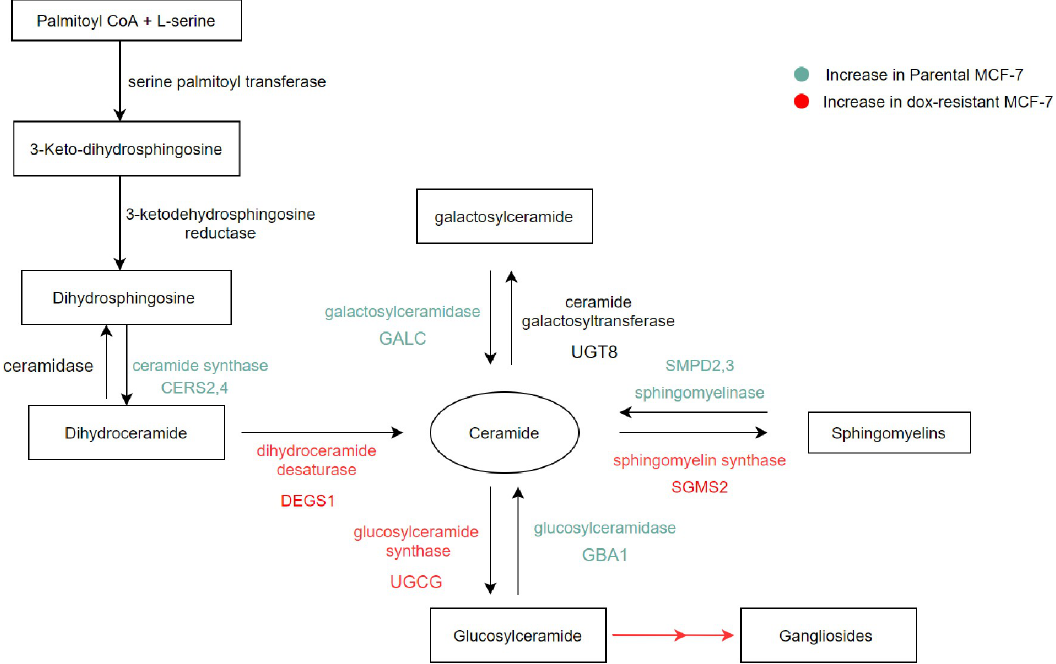
Fig 5. Proposed model for the alteration in SPLs metabolic pathways in parental versus dox-resistant MCF-7 cells.